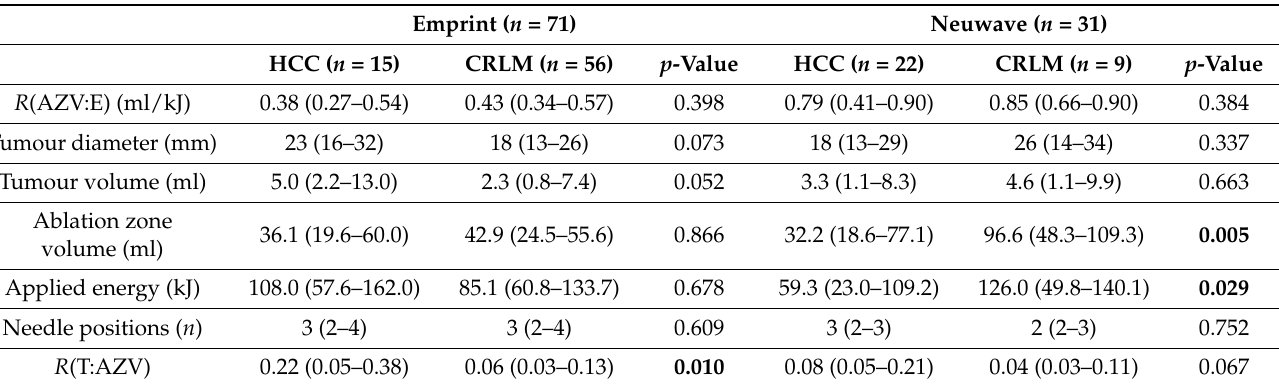
Table 3. Ablation characteristics stratified per tumour type (HCC or CRLM) according to ablation